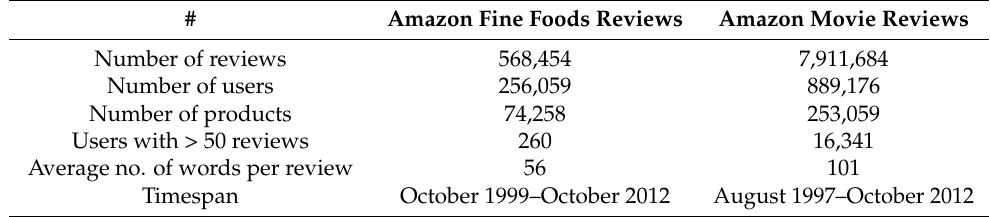
Table 1. Statistics of the